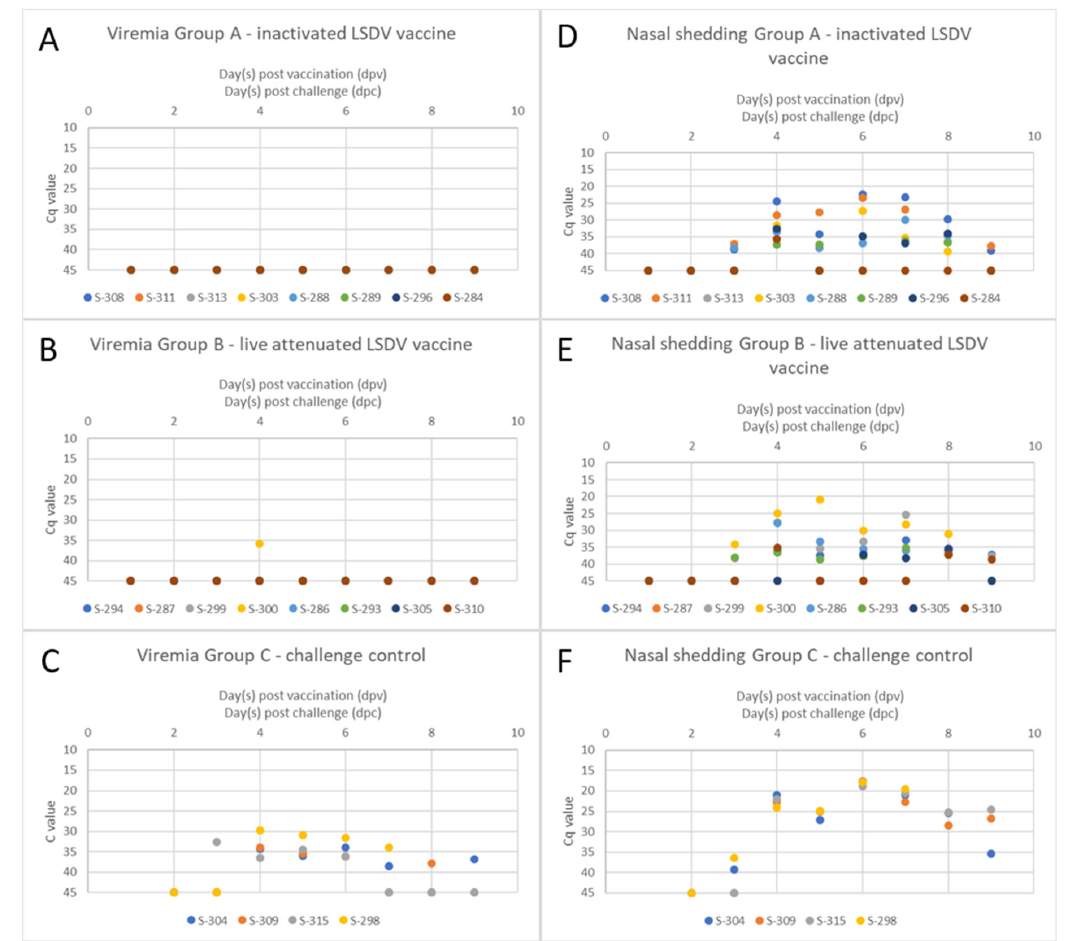
Figure 3. Viremia and viral shedding after challenge infection. ( A – C ) For the evaluation of viremia after challenge infection, EDTA blood samples were analyzed regarding their viral genome